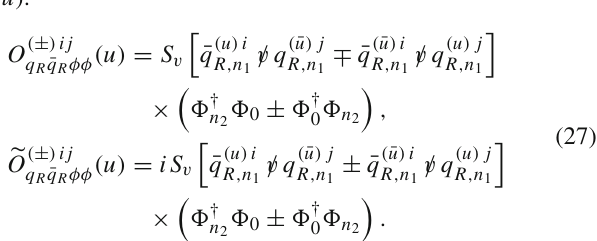
( + ) ij (left) and q R ¯ q R φφ